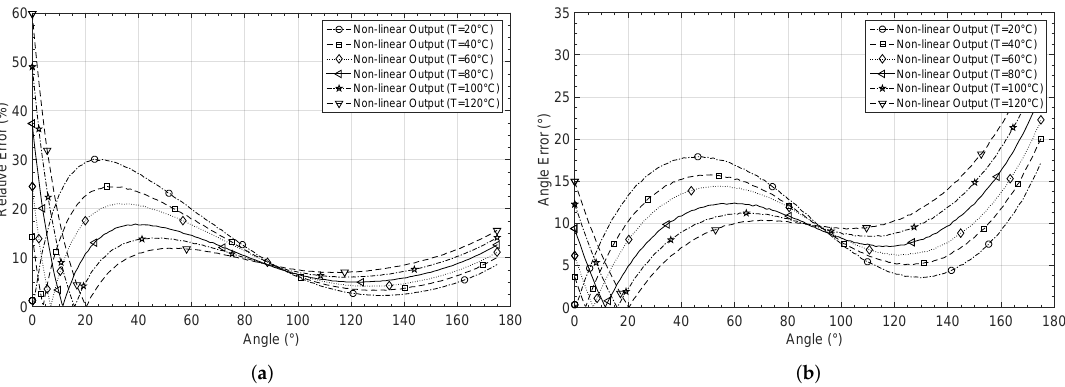
Figure 25. Calculated errors by considering the GMR non-linear characteristic at different temperatures: ( a ) relative error e r and ( b ) angle error estimation e (cid:93) .